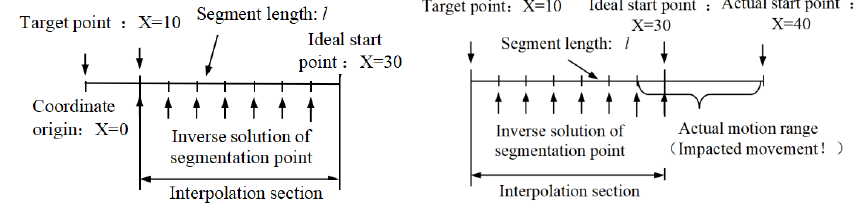
Fig. 2. The ideal Kinematic control process. Fig. 3. The misplaced Kinematic control